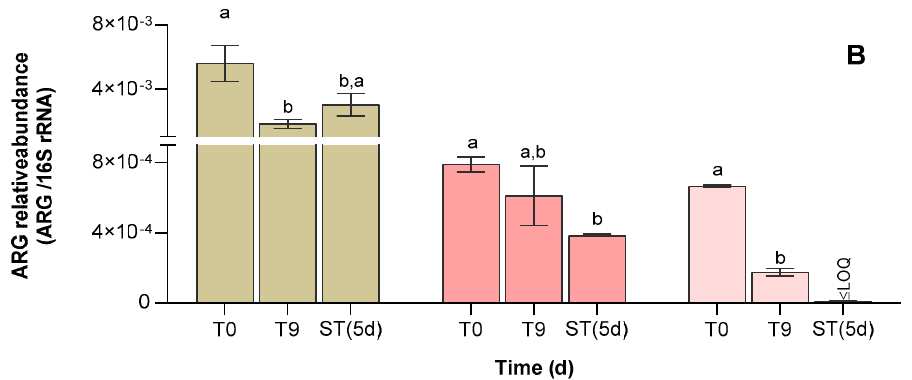
Figure 9. Abundance of the (cid:4) 16S rRNA, (cid:4) intl 1and the antibiotic resistance genes (cid:4) sul 1 and (cid:4) bla TEM ( A ) and their relative abundance (prevalence) ( B ) in the C − (raw UWW) PBR over time and after 5 d of water storage (ST5d). Results (average ± standard deviation) of abundance are expressed in gene log (gene copy number 100 mL − 1 ) and genes’ relative abundance is normalized according to 16S rRNA. Bars of the same gene with the same letter are not statistically different (two-way ANOVA followed by Tukey post hoc test p < 0.05).